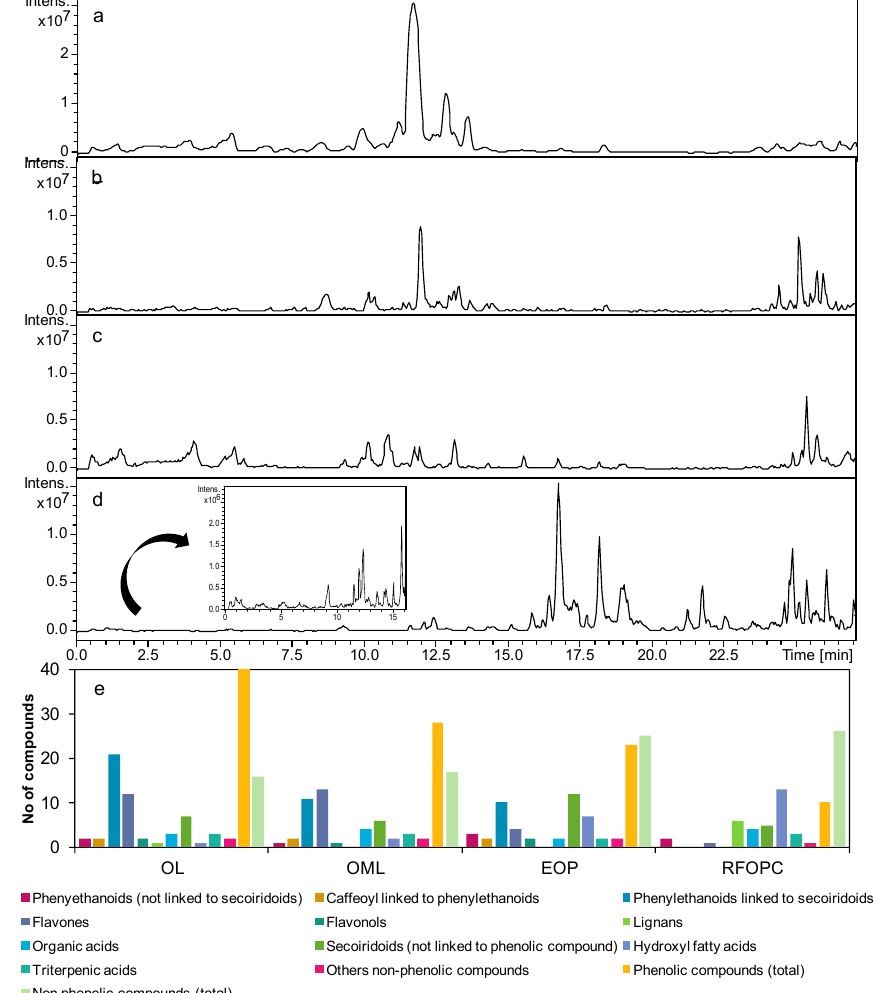
Figure 2. Base peak chromatograms of ( a ) olive leaves, ( b ) olive mill leaves, ( c ) exhausted olive pomace, and ( d ) residual fraction from olive pit cleaning obtained by RP ‐ HPLC ‐ IT ‐ MS. ( e ) Number of compounds characterized per chemical class. OL: olive leaves; OML: olive mill leaves; EOP: extracted olive pomace; RFOPC: residual fraction from olive pit cleaning.